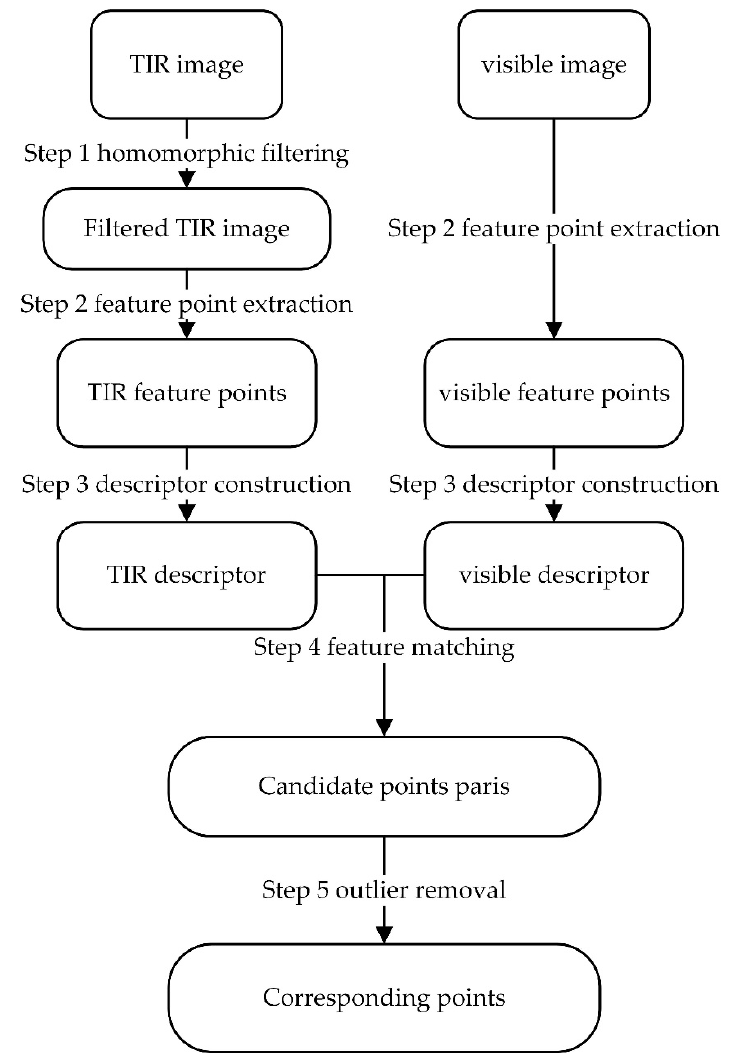
Figure 2. the process of modified RIFT. Figure 2. The process of modified